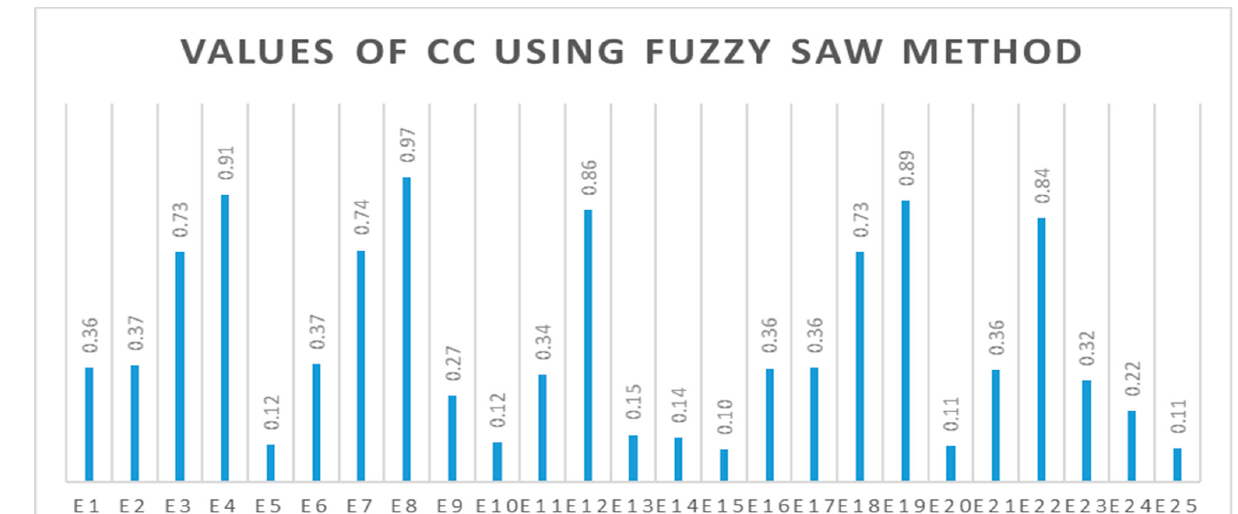
Figure 5. Values of CC using fuzzy SAW method. Table 4. Selection results with respect to optimal seeding accuracy.